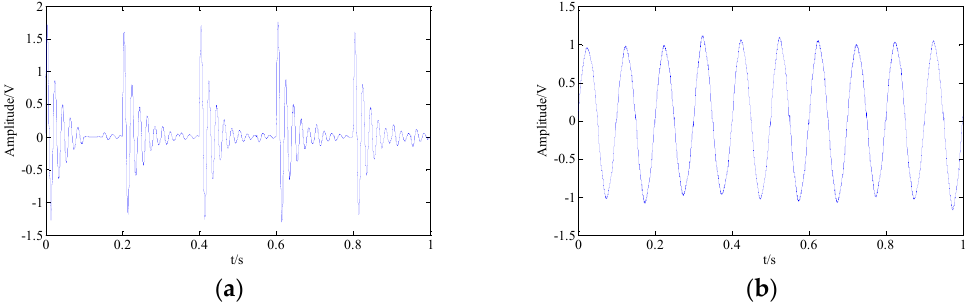
Figure 10. The analysis result provided by the proposed method: ( a ) recovered shock signal in time-domain; and ( b ) recovered harmonic signal in time-domain.